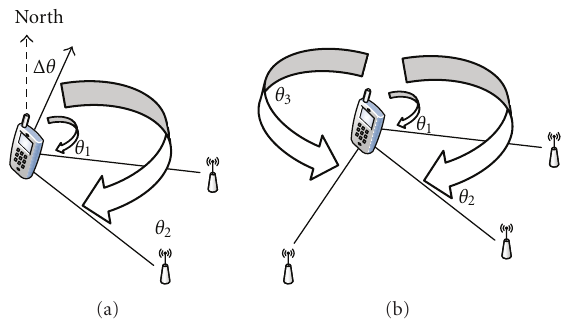
Figure 4: AoA technique representation: (a) AoA with mobile unit known orientation. (b) AoA without mobile unit known orie-